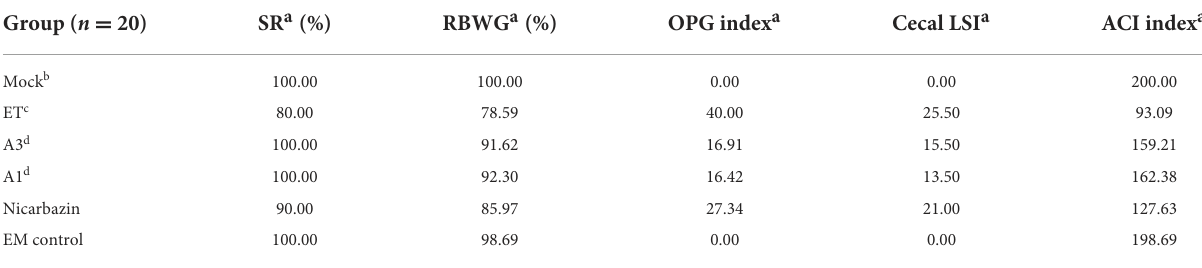
TABLE 1 Anticoccidial activity of the plant extract and essential oil mixture